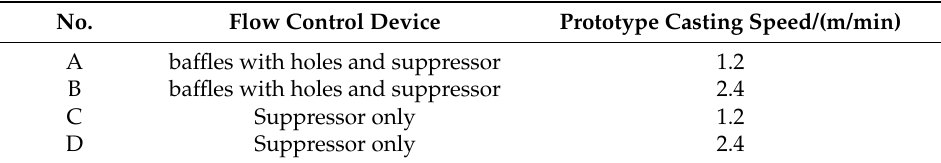
Table 2. Experimental scheme and relevant processing parameters of tundish.